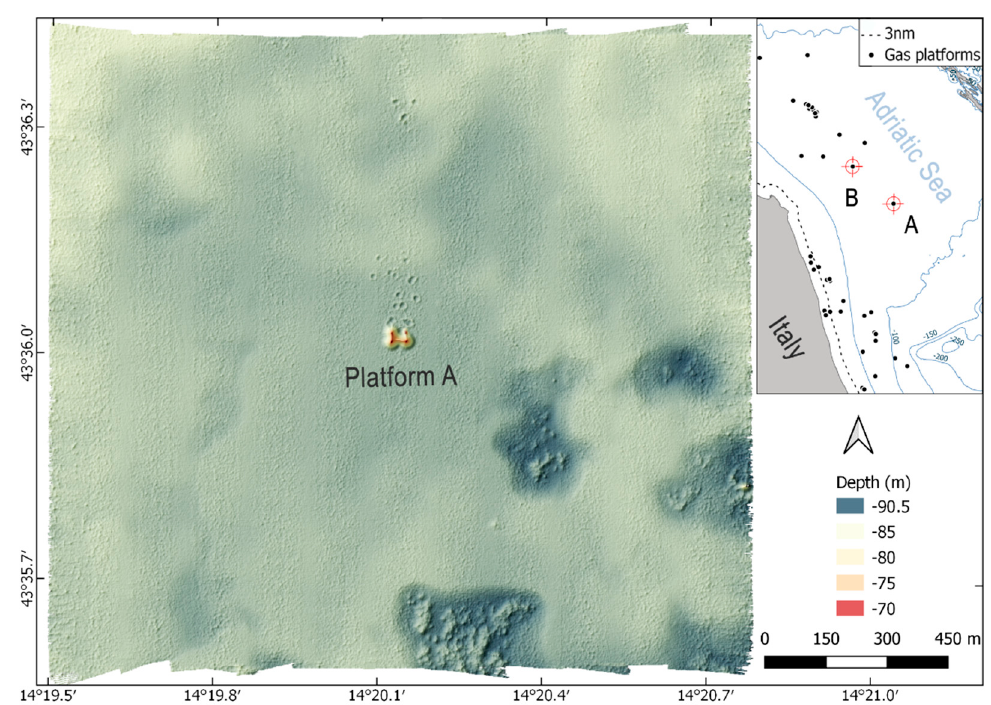
Figure 2. Site A (1.5 km × 1.5 km area surrounding the gas platform A) and related DTM (1 m resolution and 4× vertical exaggeration). The red cross symbols in the locator map highlight the location of two study sites in the Adriatic Sea.